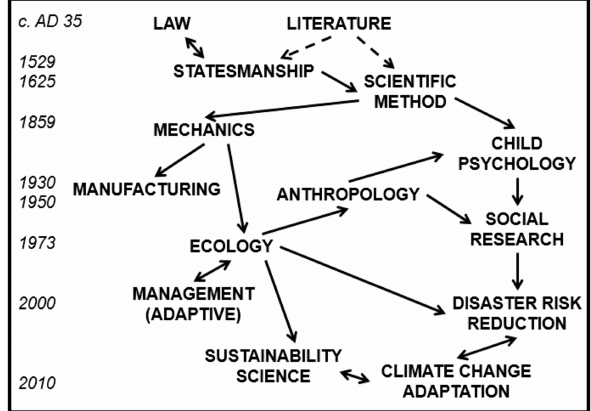
Fig. 6. Schematic diagram of the evolution of the term “resilience”.